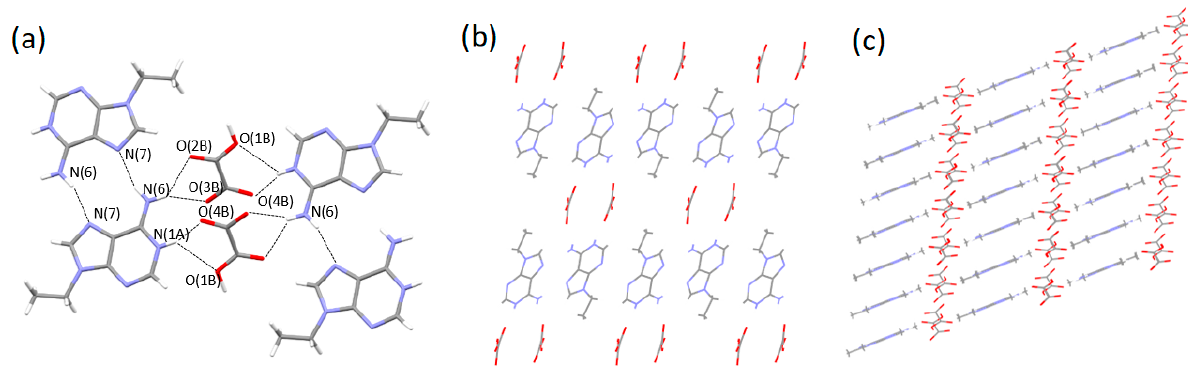
C(10A)-H(10A)···O(4B) and C(8A)-H(8A)···O(2A). The complete list of H-bonding interac- tions is shown in Table S1.